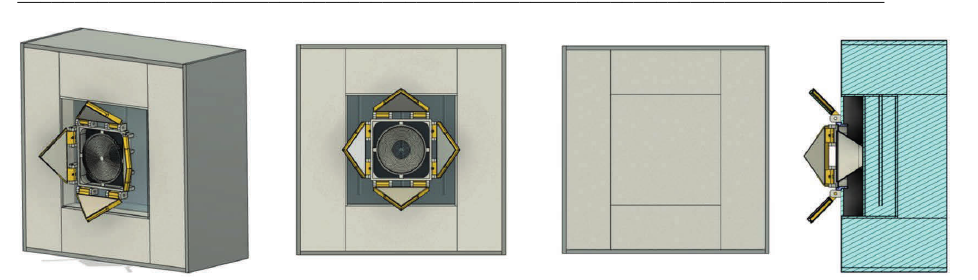
Fig. 4. Experimental stand of small-scale solar facade